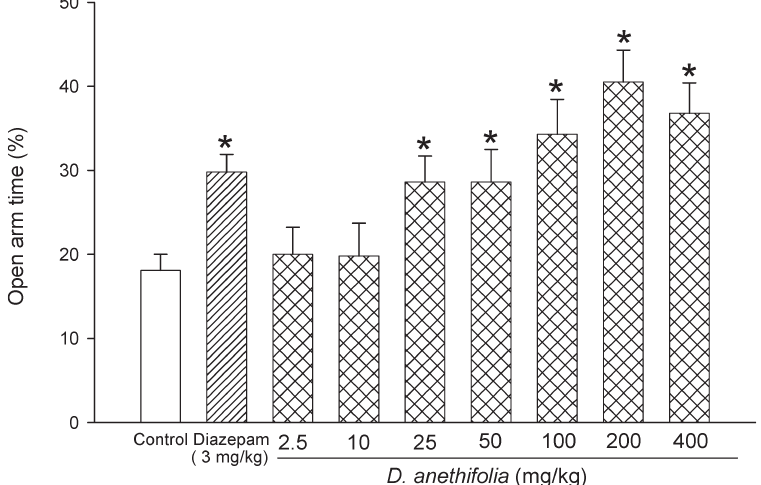
Figure 1 - Effects of diazepam, saline, and different doses of D. anethifolia on the percentage of time spent in the open arms during a 5-minute test in mice. Test compounds were injected 30 minutes prior to the EPM test. Data are presented as mean values ( ¡ S.E.M.). *P , 0.05 compared with vehicle-treated control.